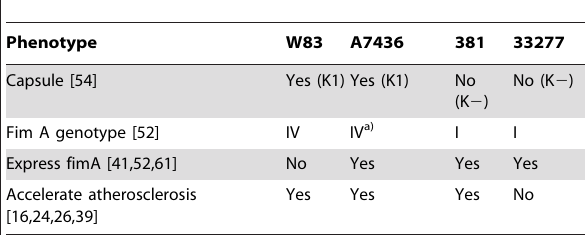
Table 1. Comparison of P. gingivalis strains.